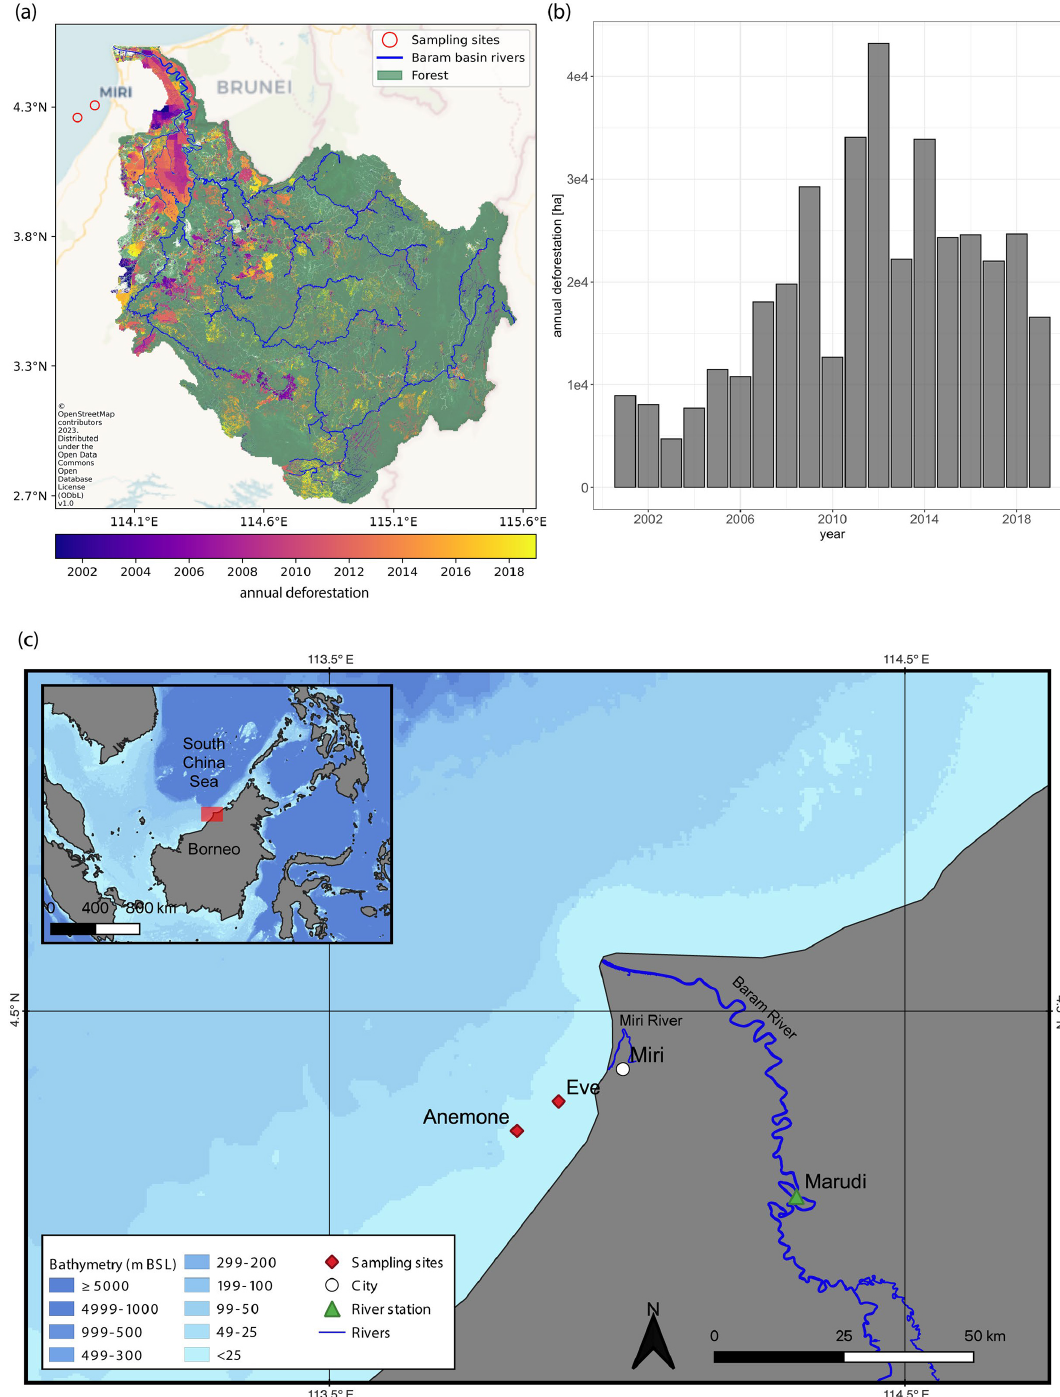
Figure 1. (a) Deforestation extent from 2001 to 2019 across the Baram River basin (map created on Python with annual deforestation data derived from the Global Forest Change dataset; Hansen et al., 2013b), (b) annual deforestation rate in the Baram River catchment in hectares between 2001 and 2019, and (c) map of the South China Sea and surrounding countries with an enlarged map of the study area both showing the bathymetry as well as the two sampling sites, Eve’s and Anemone’s Garden, the city of Miri, Miri River, and the Marudi station along the Baram River on the focused map. Map made on QGIS ® (v. 3.22.0-Białowie ˙ za) using raster data from Natural Earth (Natural Earth –